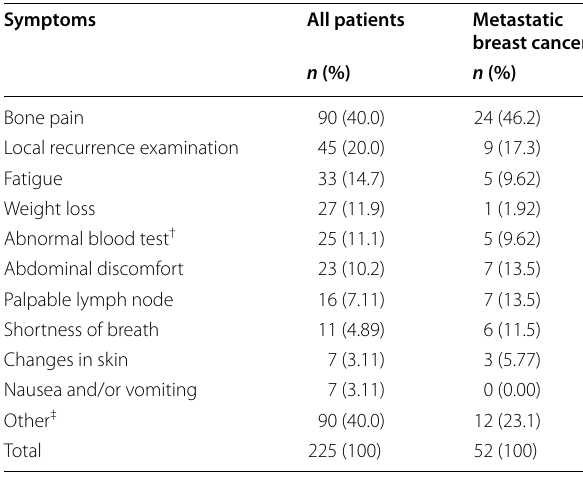
Table 1 Symptoms leading to referral for [ 18 F]FDG‑PET/CT in 225 women suspected of recurrent breast